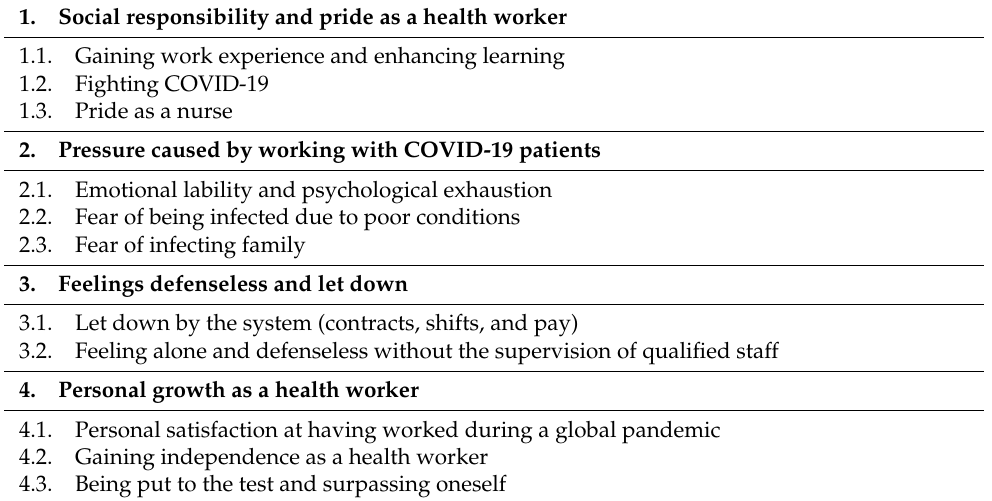
Table 3. Main theme and subtheme